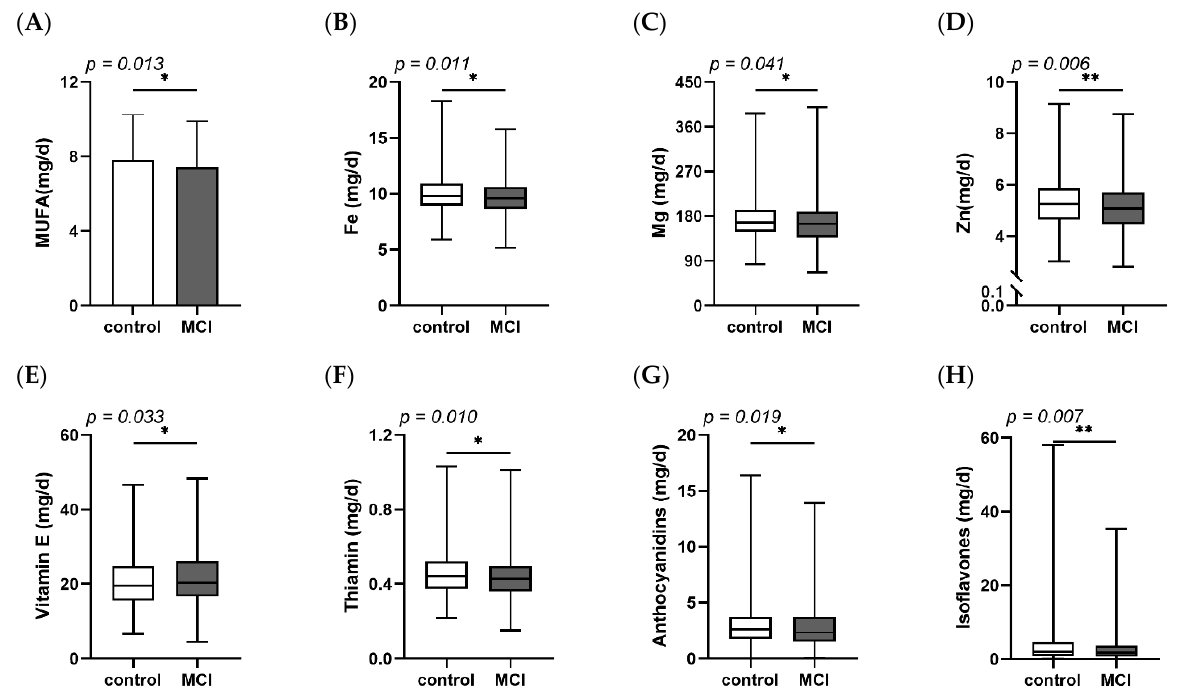
Figure 1. Dietary intake of ( A ) MUFA, ( B ) Fe, ( C ) Mg, ( D ) Zn, ( E ) Vitamin E, ( F ) Thiamin, ( G ) Anthocyanidins and ( H ) Isoflavones between control and MCI. Fe, Ferrum; MCI, mild cognitive decline; MUFA, monounsaturated fatty acids; Mg, Magnesium; Zn, Zinc. * p < 0.05, ** p < 0.01.